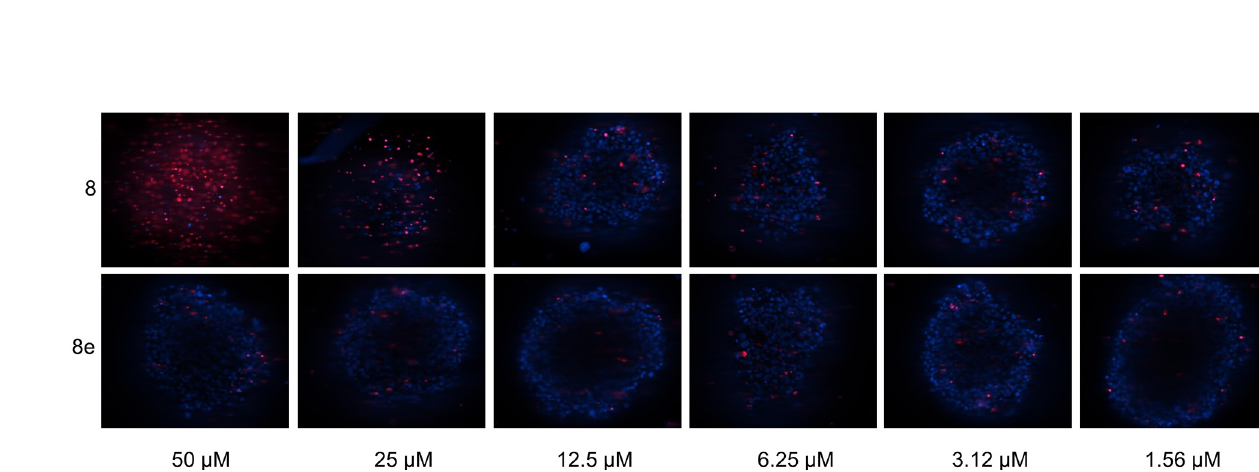
Fig 6. Compound 8 induces cell death in U87-MG spheroids. U87-MG spheroids were treated for 48 h with either compound 8 or inactive analog 8e at the indicated concentrations. Spheroids were stained with Hoechst (blue) and propidium iodide (red) to mark nuclei and dead cells, respectively. For each spheroid, one single Z ’ plane is